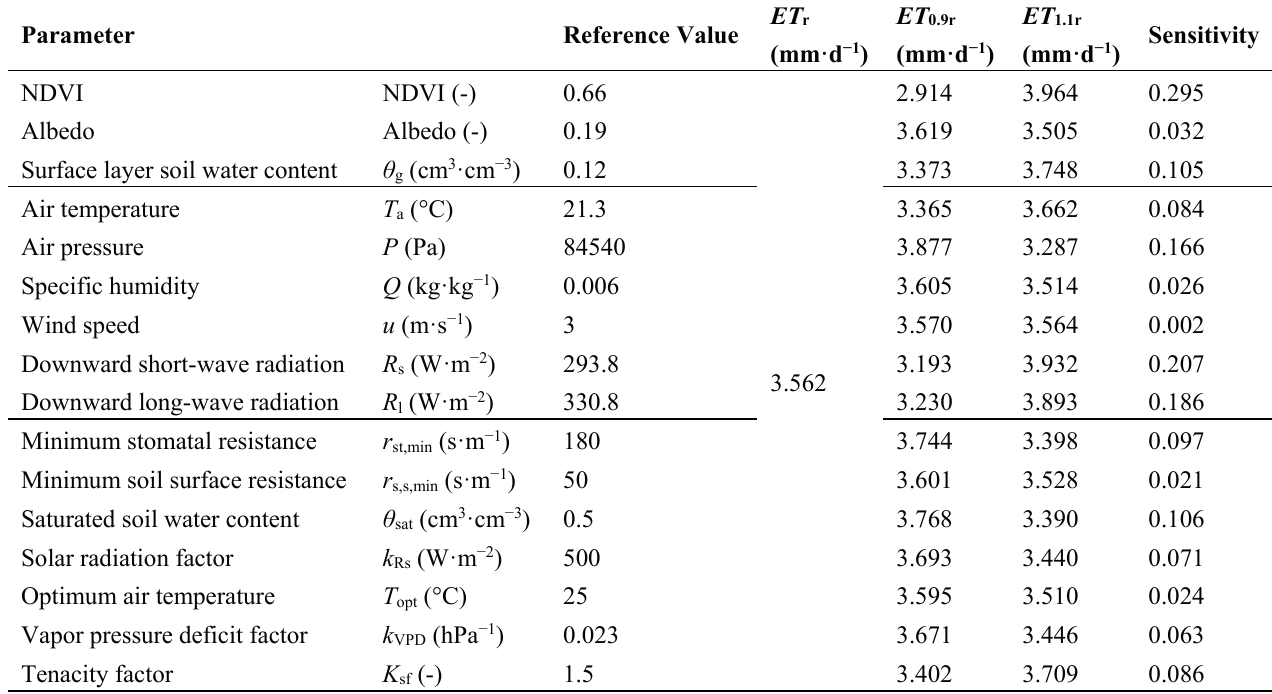
Table 2. Sensitivity of the ETMonitor to environmental and land surface biophysical parameters with ±10% range of variation in the parameters from their reference